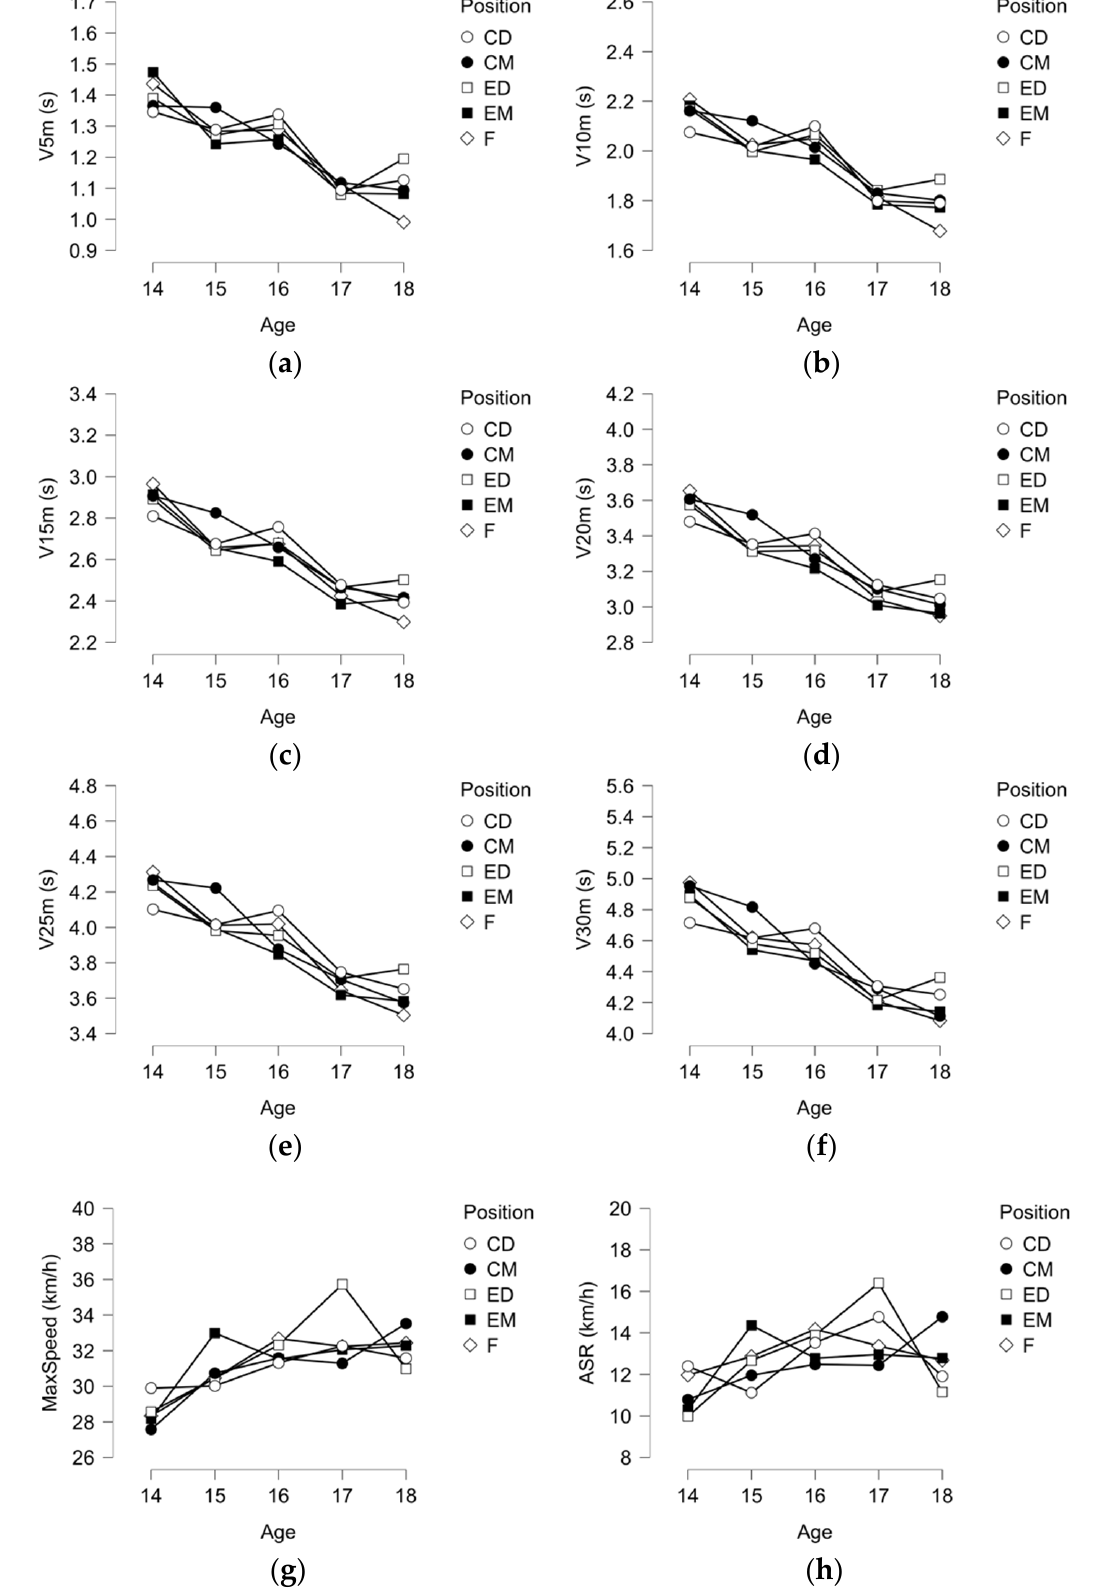
Figure 2. Descriptive plots for ( a ) 5-m; ( b ) 10-m; ( c ) 15-m; ( d ) 20-m; ( e ) 25-m; and ( f ) 30-m sprint time (s) and ( g ) maximal speed sprint (km/h); and ( h ) anaerobic speed reserve (km/h).